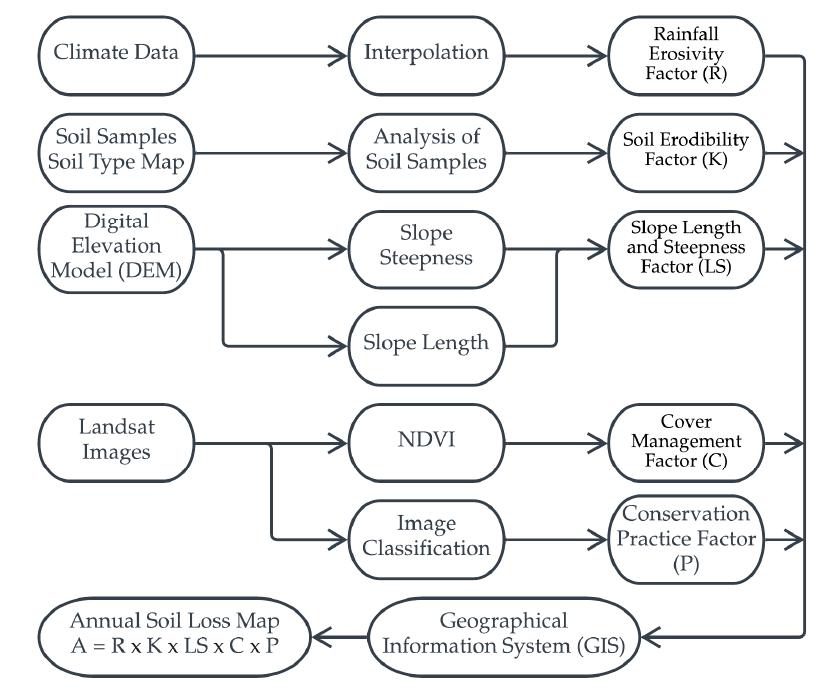
Figure 2. The methodological framework of the current research study.